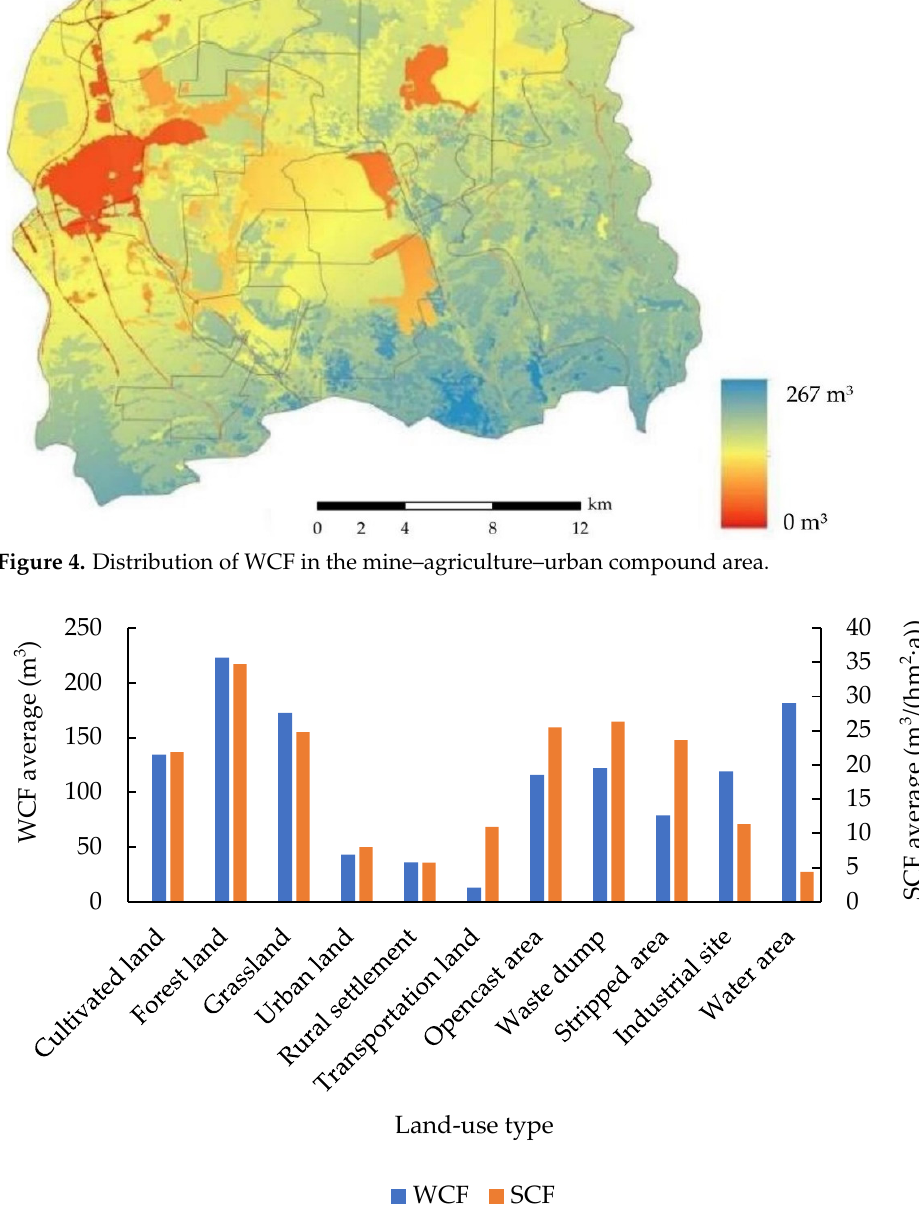
Figure 5. Average ecosystem services in different land use types.